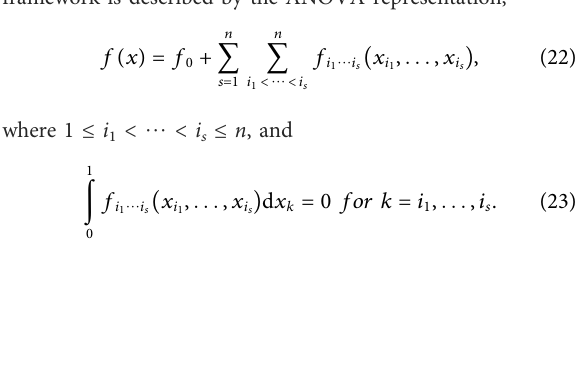
(cid:2) β > (cid:2) β < 1 and 1 is almost equal. (cid:2) β greater